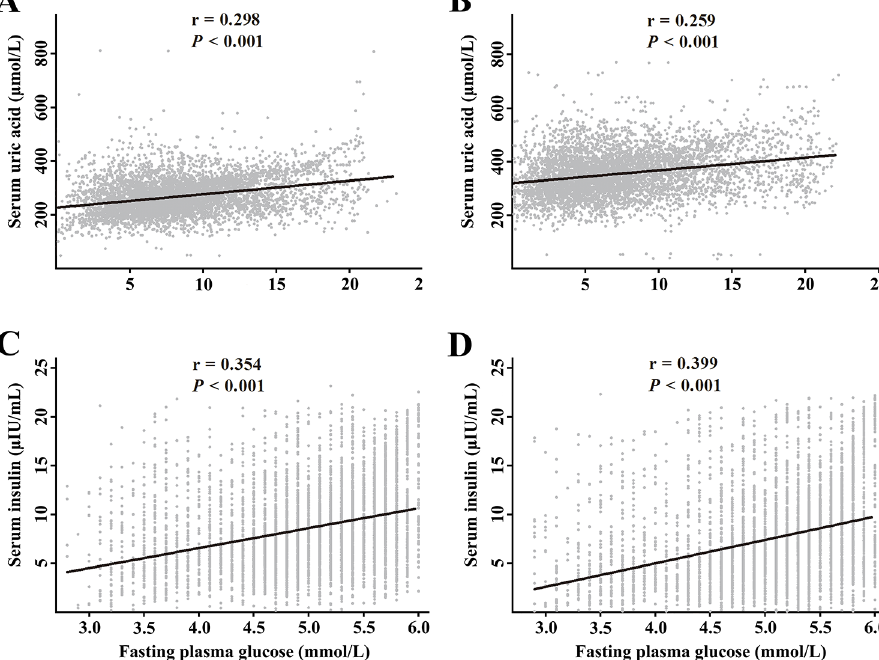
Fig 2. Relationships among serum insulin, fasting plasma glucose, and serum uric acid. Positive relationship betweenserum insulinand serum uric acid in women (A) and in men (B). Positive relationship betweenfasting plasma glucoseand serum insulinin women (C) and in men